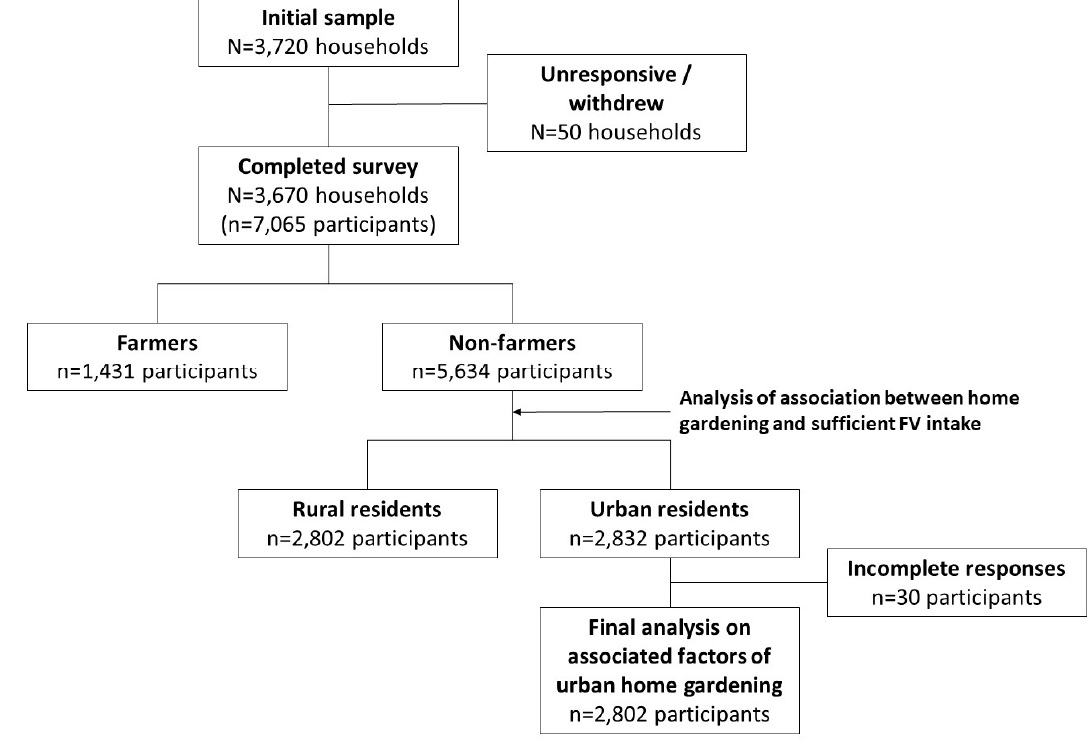
Figure 1. Sample selection flowchart.